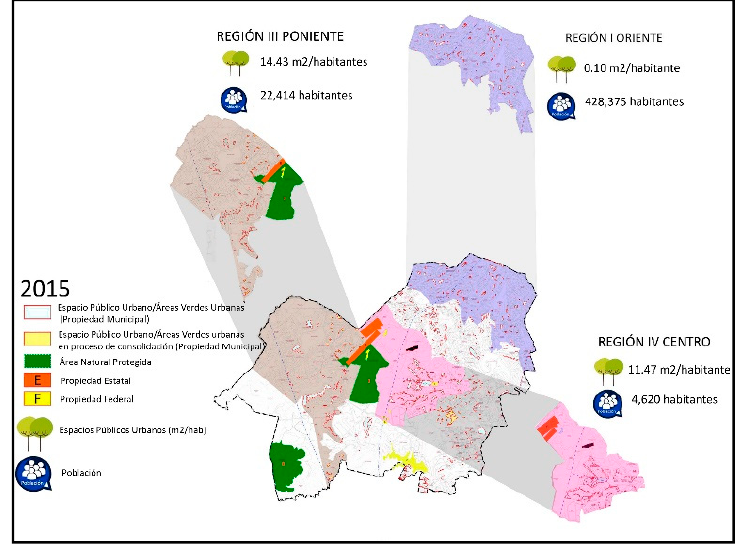
Figure 7. Micro-regional distribution of UPS (by Pérez-P, 2016).